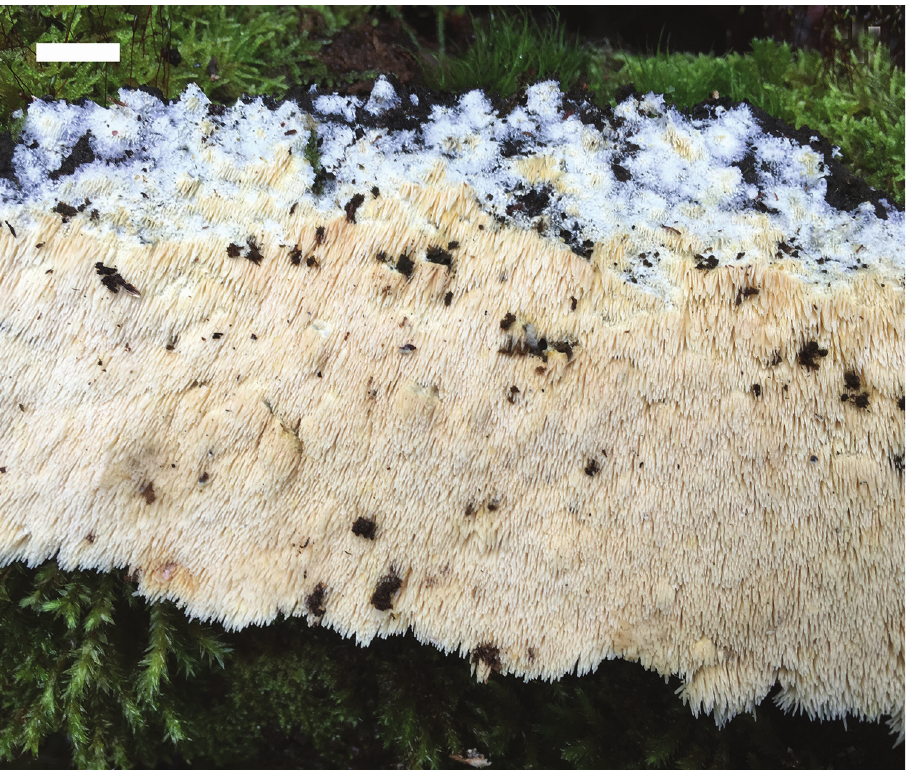
Figure 2. A fresh basidiocarp of Dentipellis tasmanica (holotype). Scale bar: 1 cm. number: MH571703); Mt Field National Park, 42°41'S, 146°42'E, elev., 180 m, on fall- en trunk of Nothofagus sp., 14 May 2018, Dai 18737 (M, duplicate in BJFC; ITS Gen- Bank accession number: MH571698, 28S GenBank accession number: MH571701).